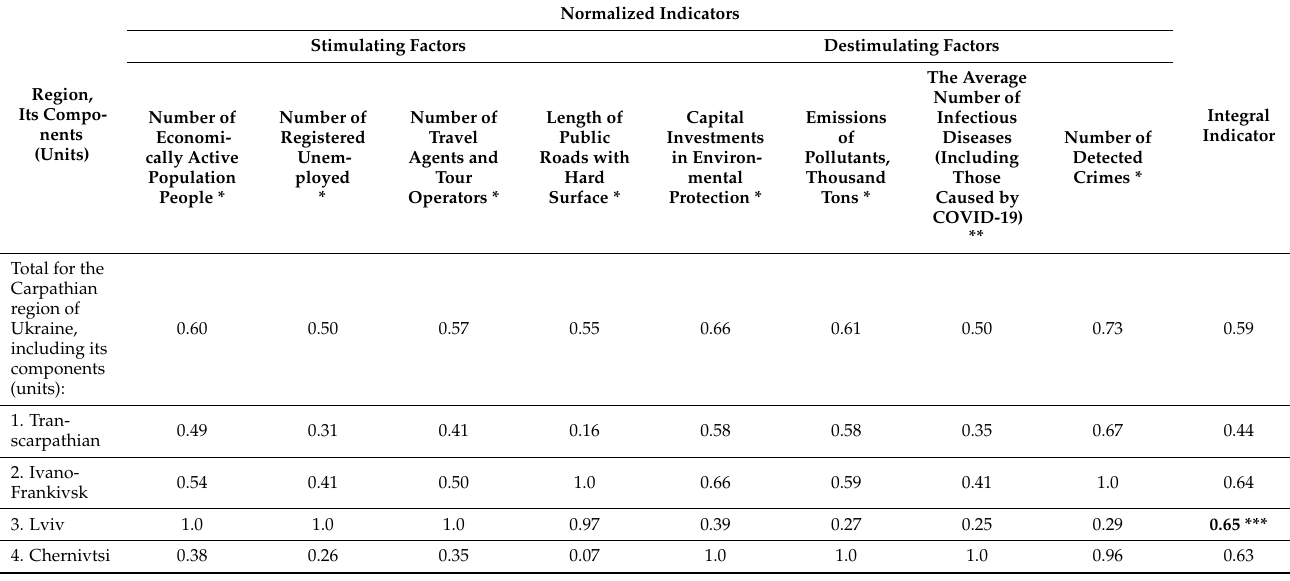
Table 5. Normalized indicators and the integral indicator for assessing the level of use of tourist potential of the Carpathian region of